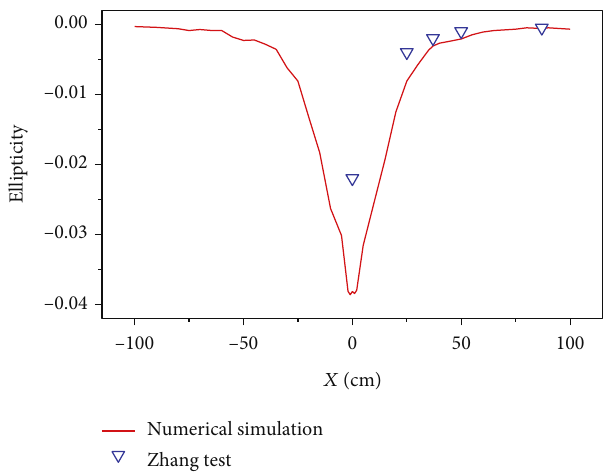
Figure 3: Comparison between fi nite element simulation and experimental results in reference